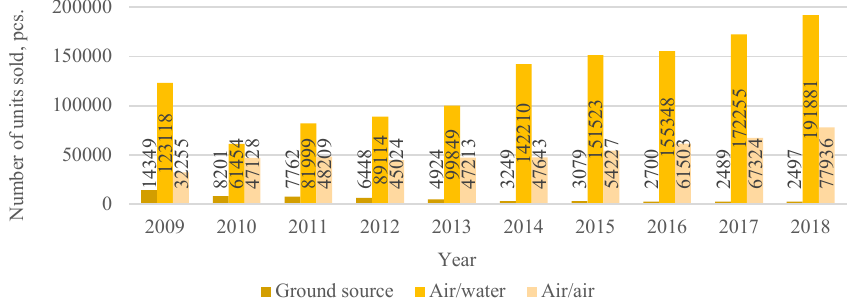
Fig. 6. The number of heat pumps sold in France by type.